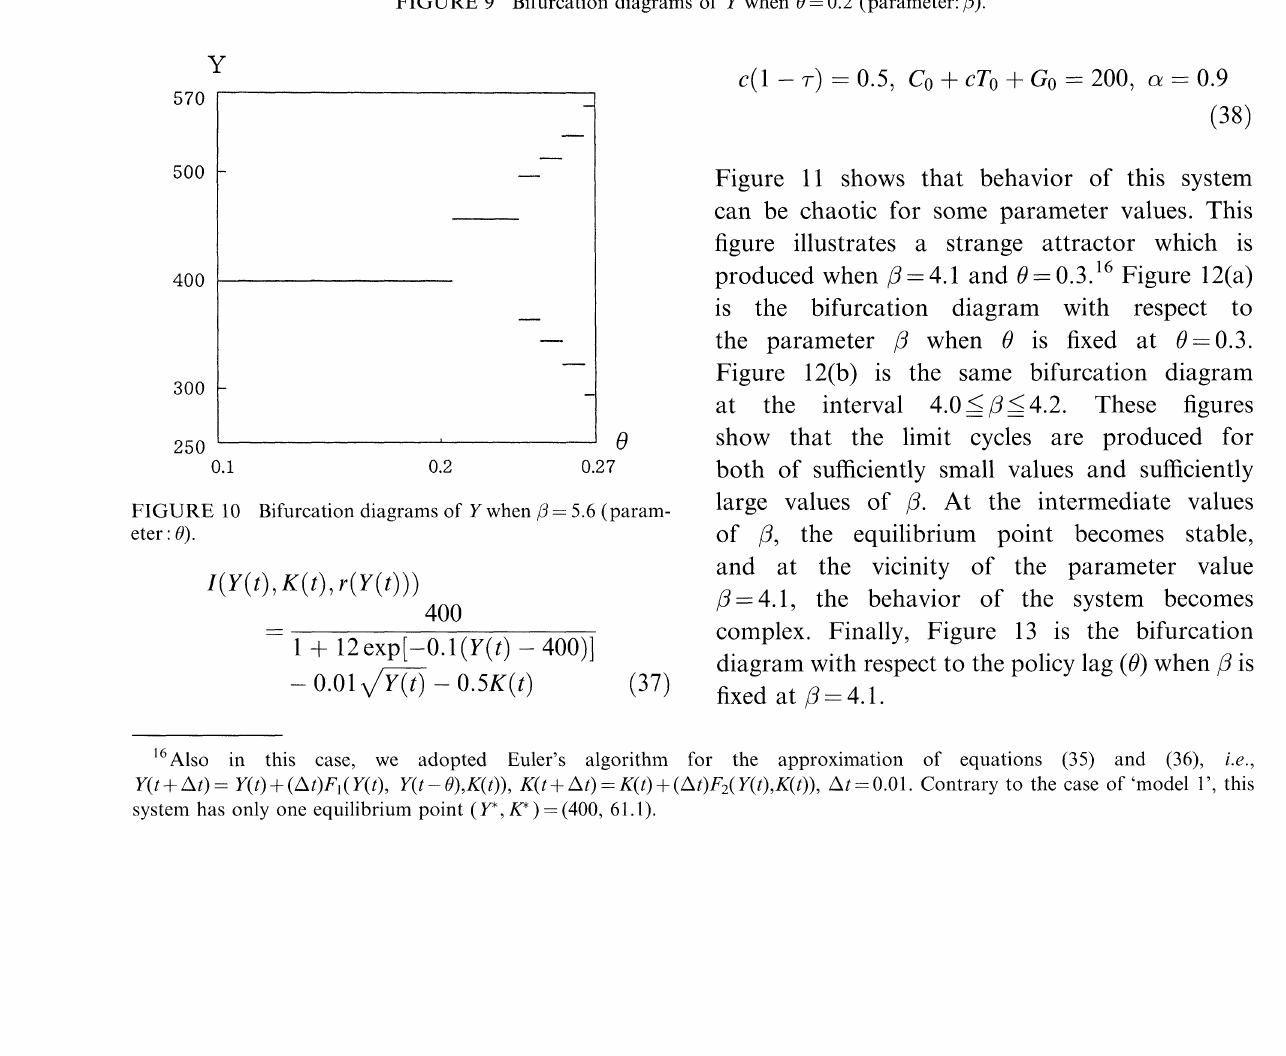
FIGURE 9 Bifurcation diagrams of Y when 0=0.2 (parameter:/3).